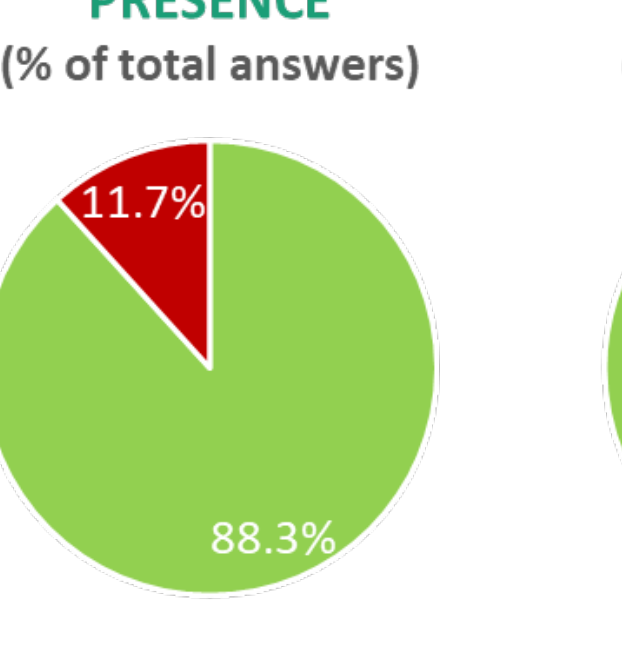
Figure 7. Percentage of right and wrong answers provided by the participants to the subjects cov- ered in the In-presence ( left ) and Remote ( right ) conditions.